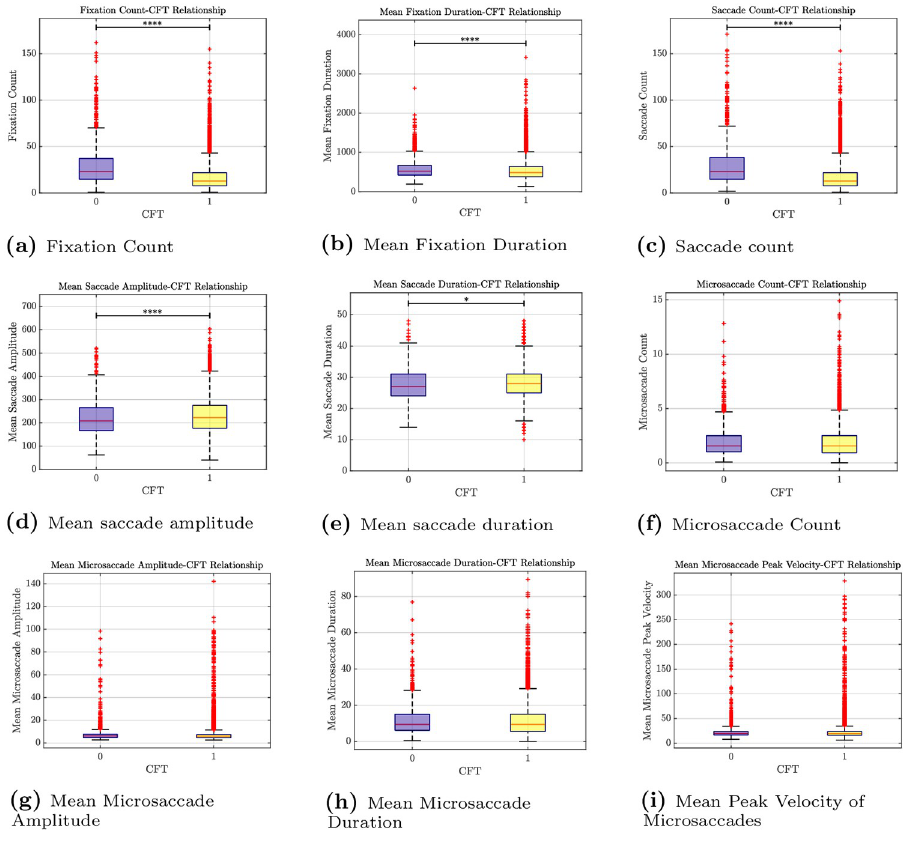
Fig 2. Eye movement differences between the incorrectly answered (purple) and correctly solved items (yellow). (a) Fixation Count. (b) Mean Fixation Duration. (c) Saccade count. (d) Mean saccade amplitude. (e) Mean saccade duration (f). Microsaccade Count. (g) Mean Microsaccade Amplitude. (h) Mean Microsaccade Duration. (i) Mean Peak Velocity of